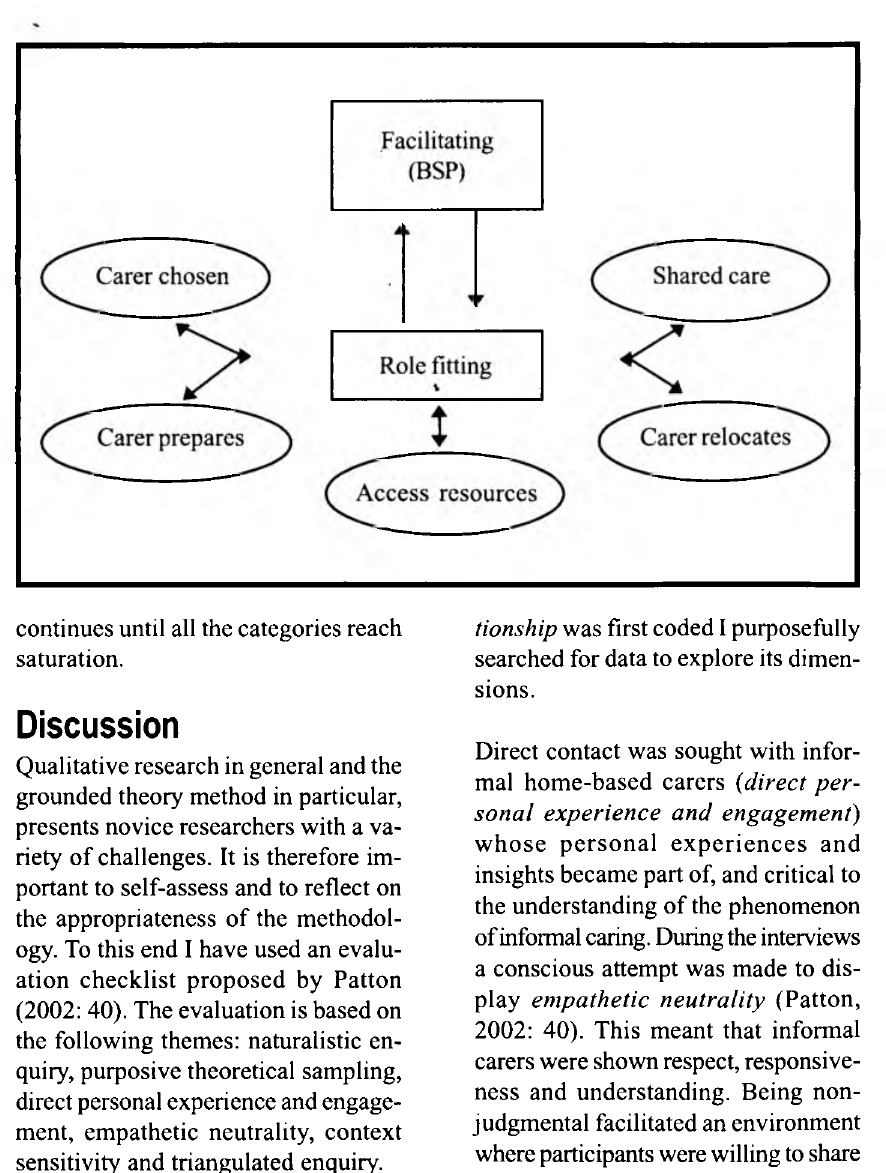
Figure: 2 - Role Fitting (Action and interaction